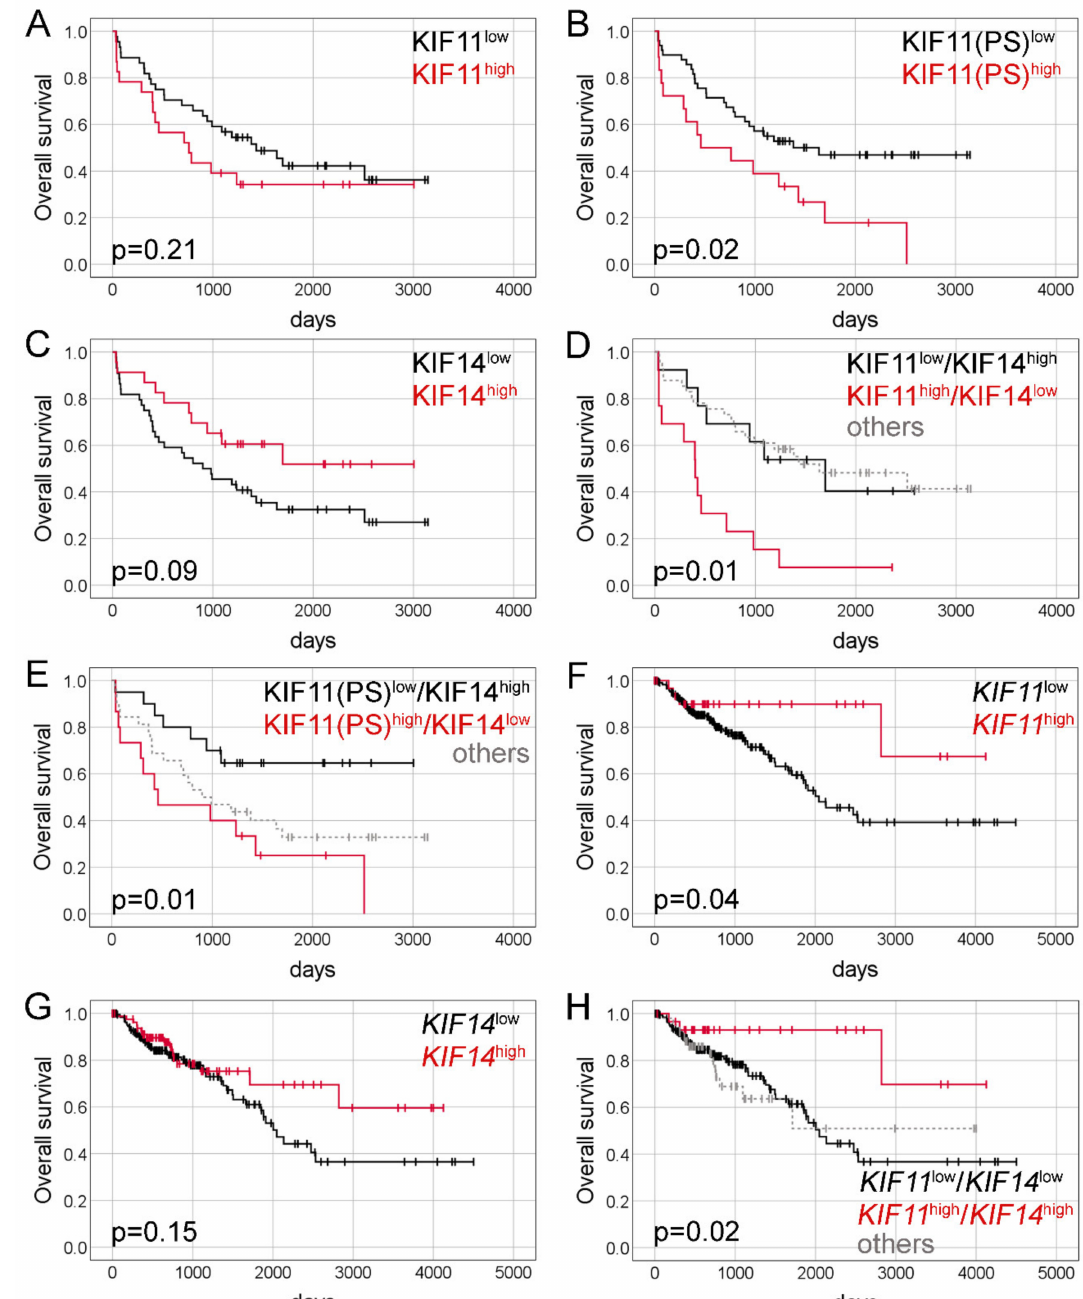
Figure 3. Kaplan-Meier curves presenting the overall survival of CRC patients depending on KIF11 protein expression ( A ); KIF11 protein expression assessed based on PS values ( B ); KIF14 protein expression ( C ); combined KIF11 (IRS)/KIF14 protein expression ( D ); combined KIF11(PS)/KIF14 protein expression ( E ); KIF11 mRNA expression ( F ); KIF14 mRNA expression ( G ) and combined KIF11 / KIF14 mRNA expression ( H